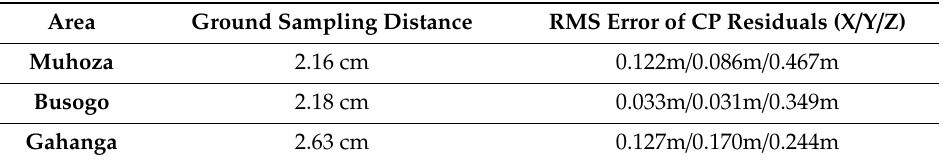
Table 8. Specifications of final results.